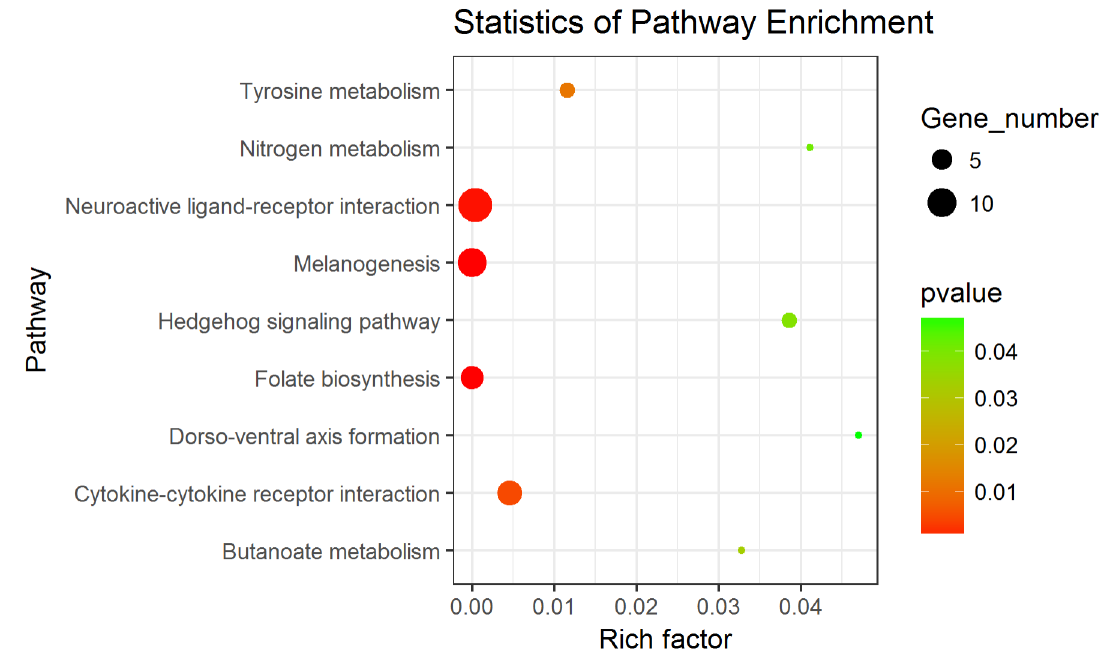
Fig 3. KEGG pathways enrichment in RNA-seq (p < 0.05). Gene number: numberof target genesin each pathway.Rich factor: the ratio of the numberof target genes dividedby the numberof all the genesin each pathway.